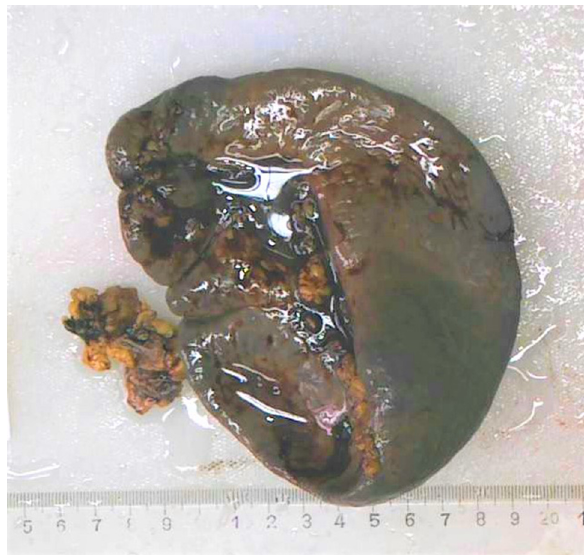
Figure 3: The postoperative pathology report con fi rmed the diag - nosis of a true splenic artery